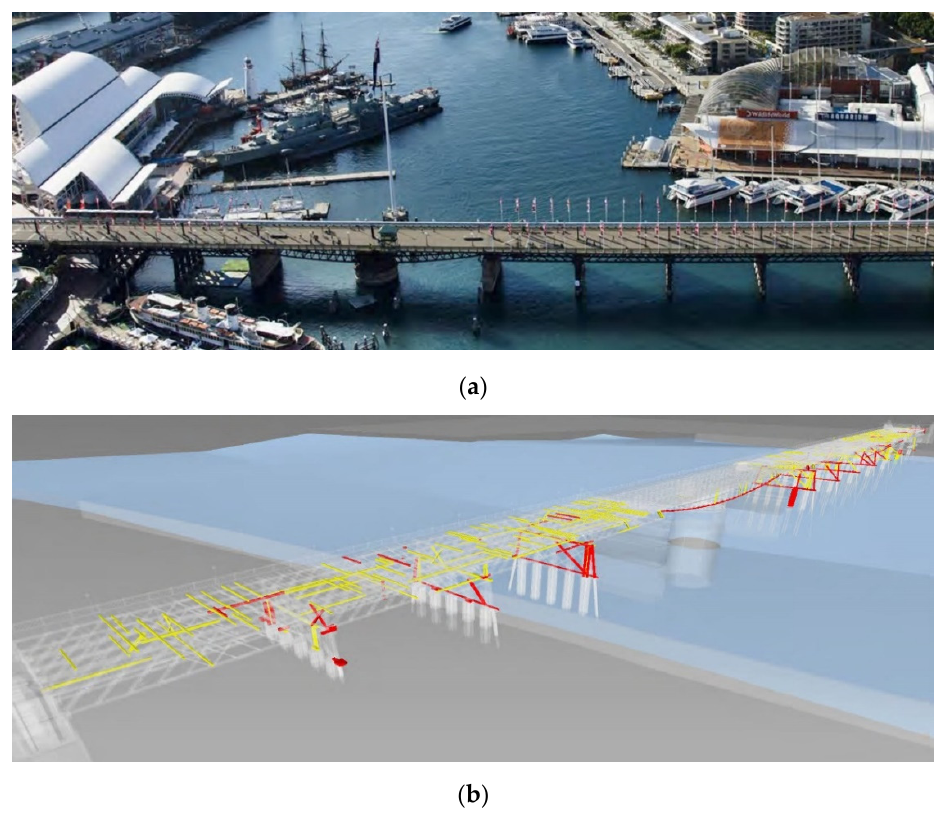
Figure 11. Development of BrIM for Pyrmont Bridge, Sydney: ( a ) current form; ( b ) original / non-original fabrics over time as a BrIM output [218].